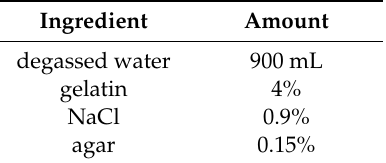
Table 1. Portion of ingredients used for making